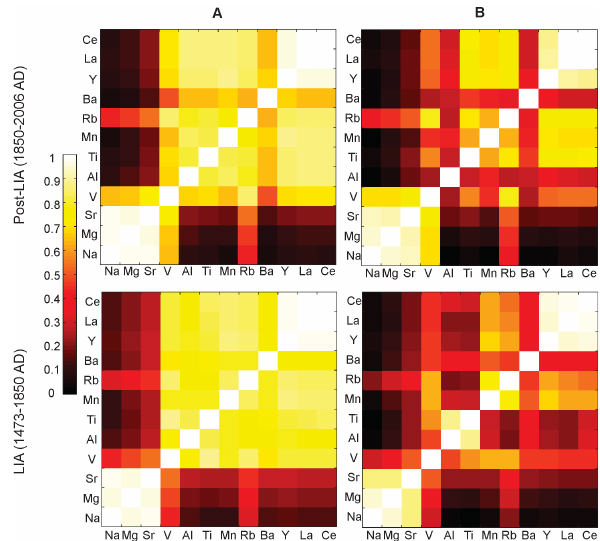
Figure 8: Correlation matrices of ICP-MS element concentration data from post-LIA (1850– 1 Fig. 8. Correlation matrices of ICP-MS element concentration data 2006) (upper panel) and LIA (1474–1850) (lower panel). Matrices are shaded according to 2 from post-LIA (1850–2006) (upper panel) and LIA (1474–1850) the value of the correlation coefficient. A) Matrices on the left panel are correlations results 3 (lower panel). Matrices are shaded according to the value of the of minimum covariance determinant (MCD) estimator (h = 0.75n), a robust method which 4 correlation coefficient. (A) Matrices on the left panel are correla- removes the effect of statistical outliers (Rousseeuw, 1984). B) Matrices on the right panel 5 tion results of minimum covariance determinant (MCD) estimator display correlations performed on raw data of non-Gaussian distribution. 6 ( h =0.75 n ), a robust method that removes the effect of statistical outliers (Rousseeuw, 1984). (B) Matrices on the right panel display correlations performed on raw data of non-Gaussian distribution.